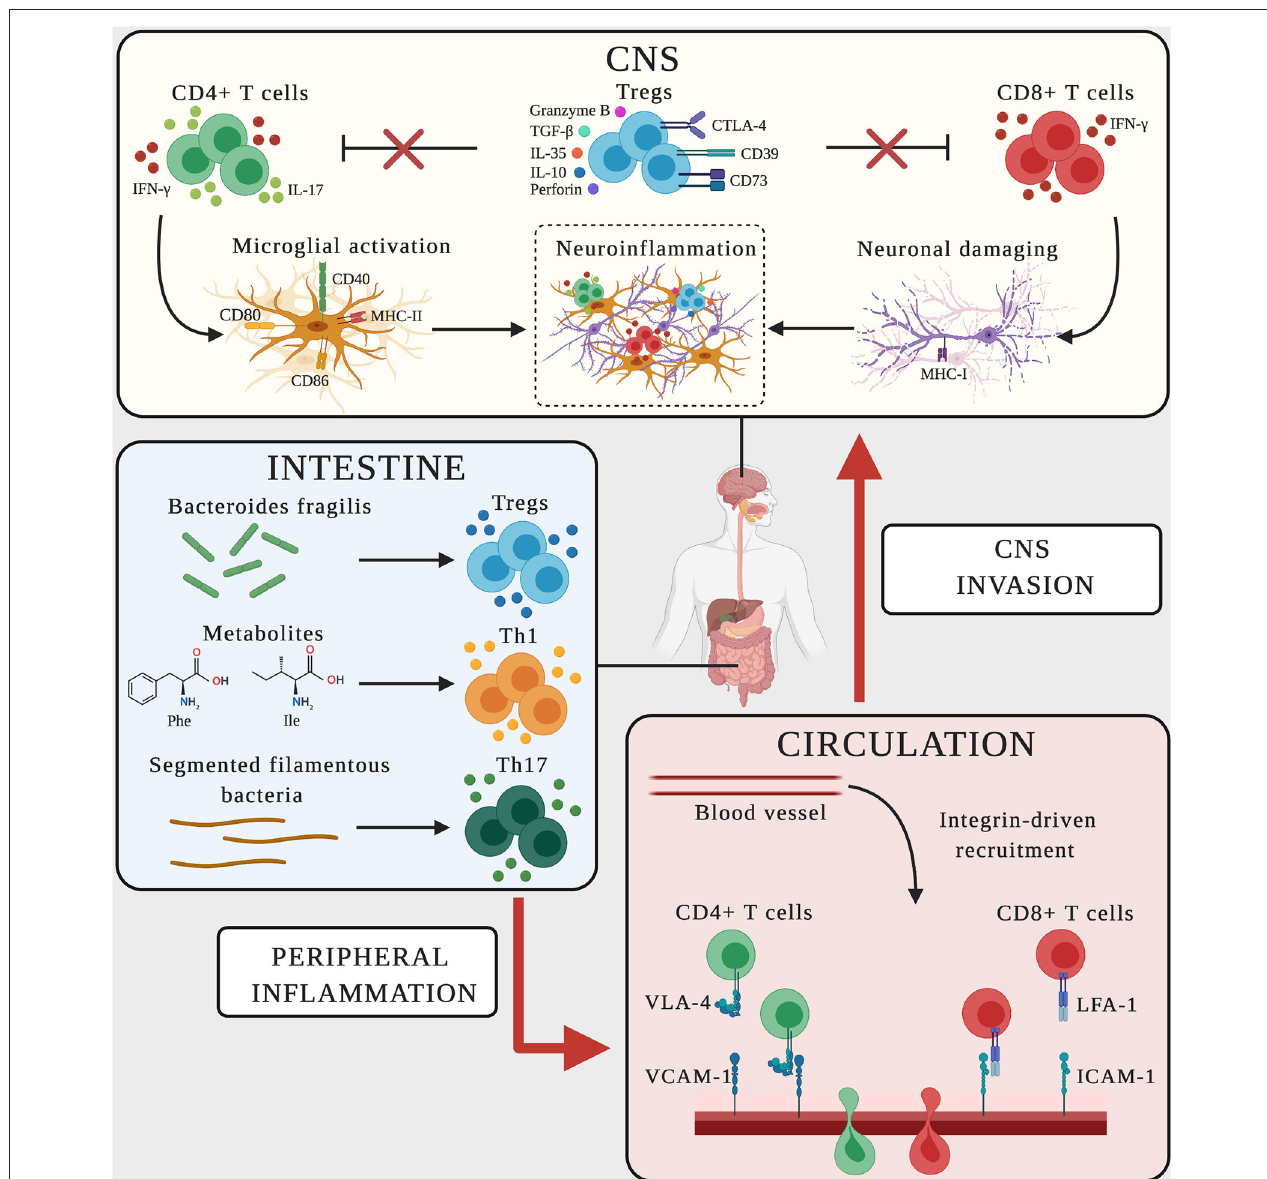
FIGURE 2 | Schematic representation of adaptive immune mechanisms in MS and AD. In CNS, CD4 + T cells producing the pro-inflammatory mediators IFN- γ -and IL-17 promote microglial activation, upregulating the expression of CD40, MHC-II, CD80, and CD86 on the surface and favoring neuroinflammation. CD8 + T cells producing IFN- γ bind neurons expressing MHC-I, triggering neuronal damage and boosting neuroinflammation. Dysregulated T reg cells fail to suppress effector T cell functions (red crosses), thus sustaining the neuroinflammatory environment. In the intestine, the microbiome and its metabolites influence the polarization and activation of T cells. Bacteroides fragilis promotes the expansion of T reg cells, the amino acids phenylalanine and isoleucine induce the differentiation of Th1 cells, and segmented filamentous bacteria trigger Th17 cell polarization. Vascular endothelial cells express the LFA-1 and VLA-4 counter-ligands (ICAM-1 and VCAM-1) guiding the transmigration of peripherally activated T cells from the circulation to the